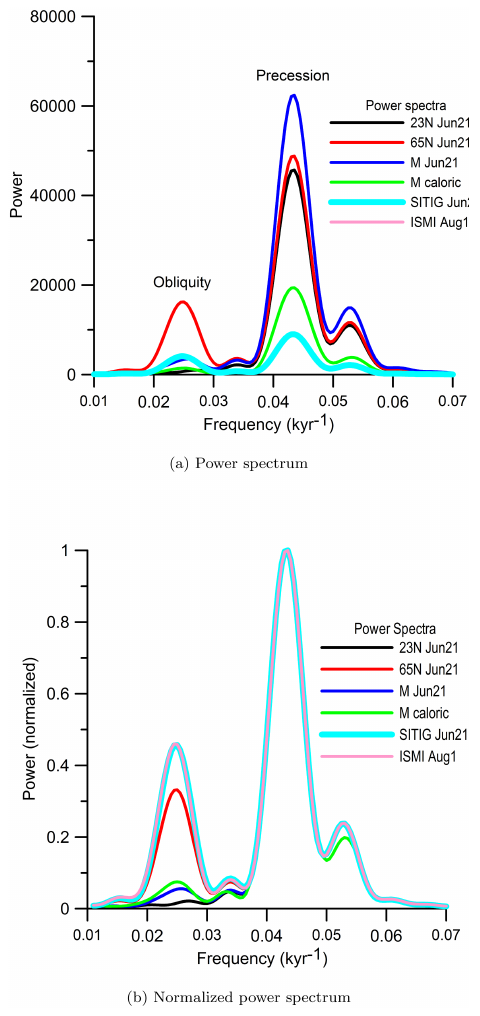
Figure 3. Power spectra of insolation curves in Fig. 2. Panel (a) shows the power spectrum in an absolute sense and (b) the nor- malized power spectrum. For (b) , each curve is divided by its peak power at ∼ 0.043kyr − 1